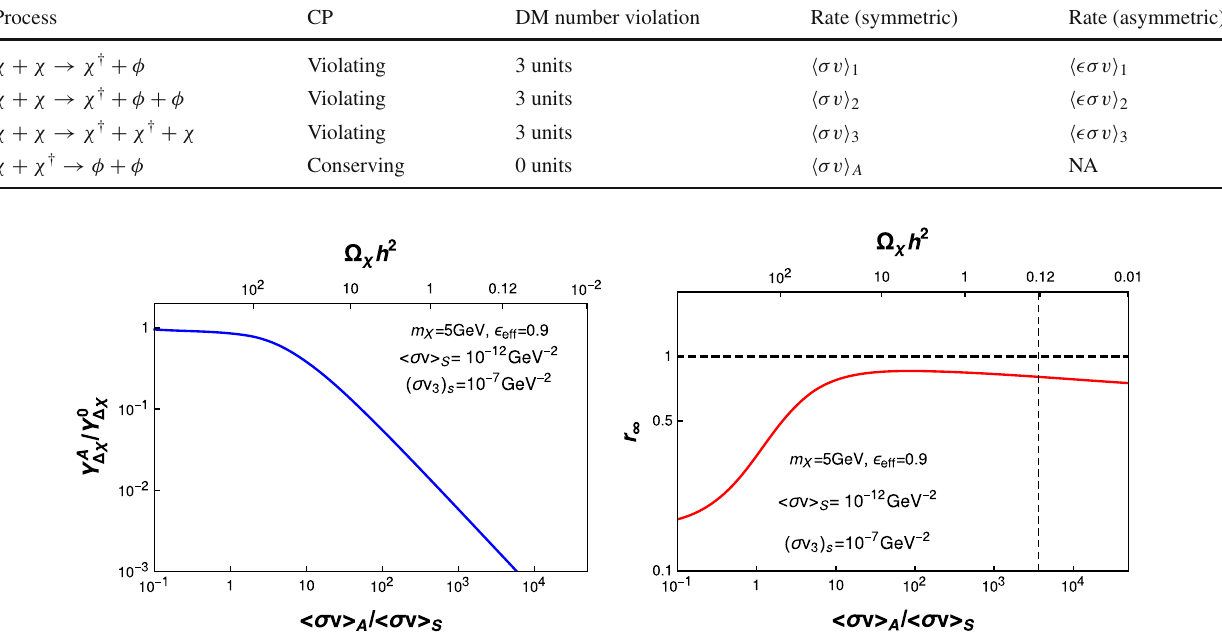
Fig. 4 Same as Fig. 3, for the asymmetric DM from semi-annihilation scenario discussed in Sect. 3.2. See text for details